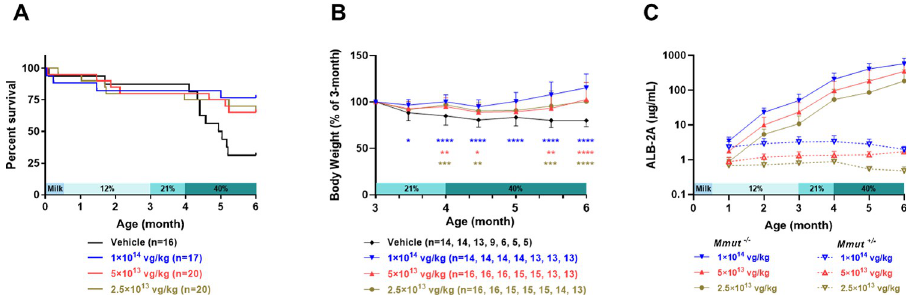
Fig 4. Effect of high protein diet challenge on MMA mice treated with vehicle or three dose levels of mLB-001 at PND 1. (A) Kaplan-Meier survival curves of MMA mice injected with vehicle or different doses of mLB-001. Log-rank test demonstrated significantly better survival of all three mLB-001-treated groups than the vehicle group during diet challenges ( P < 0.05). (B) Change in body weight of MMA mice in response to the high protein diet challenge. The body weight of each Mmut-deficient animal was normalized to its weight at the introduction of the 21% protein diet. At all dose levels, mLB-001-treated animals demonstrated better maintenance in body weight than the vehicle-treated animals. Females and males were combined due to a lack of significant difference. Numbers in parentheses in the legends represent animal numbers at each timepoint. � P < 0.05, �� P < 0.01, ��� P < 0.001, ���� P < 0.0001, mixed- effects analysis with multiple comparisons between vehicle- and each mLB-001-treated group at the indicated timepoints. (C) Dose-dependent plasma ALB-2A levels demonstrated exponential increases over time in all mLB- 001-treated MMA mice while remaining stable in all treated heterozygous animals. The rate of ALB-2A increase in the MMA mice was similar across all 3 treatment groups.